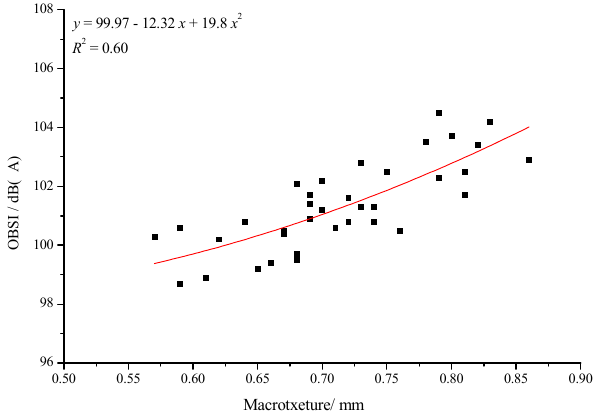
Figure 5. Regression analysis between macrotexture of longitudinal groove pavement and tire/road noise.